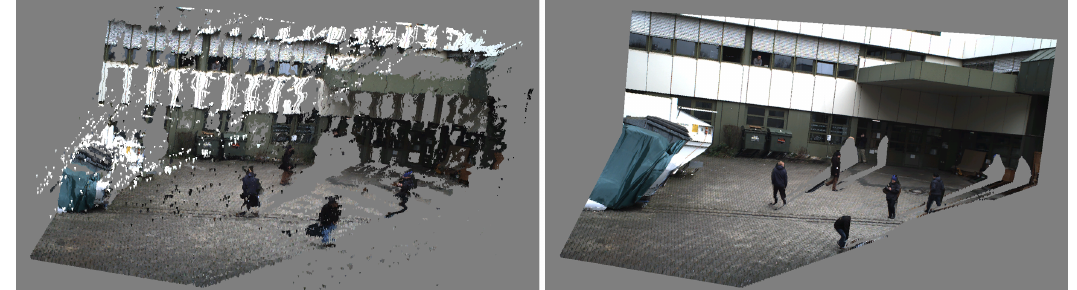
Figure 3. ( Left ) Point cloud reconstructed from a stereo camera using classical stereo block matching. ( Right ) Point cloud reconstructed with our geometrically based monocular depth